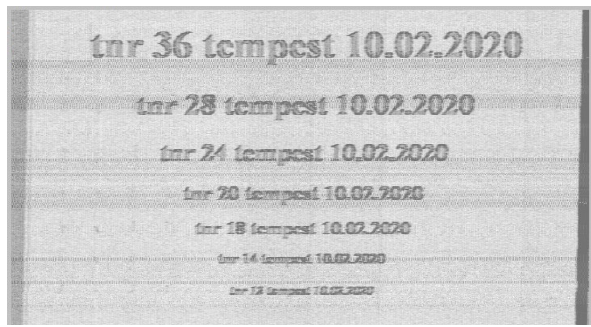
Figure 7. Image recovered when Times New Roman font was displayed—R&S FSET receiver.